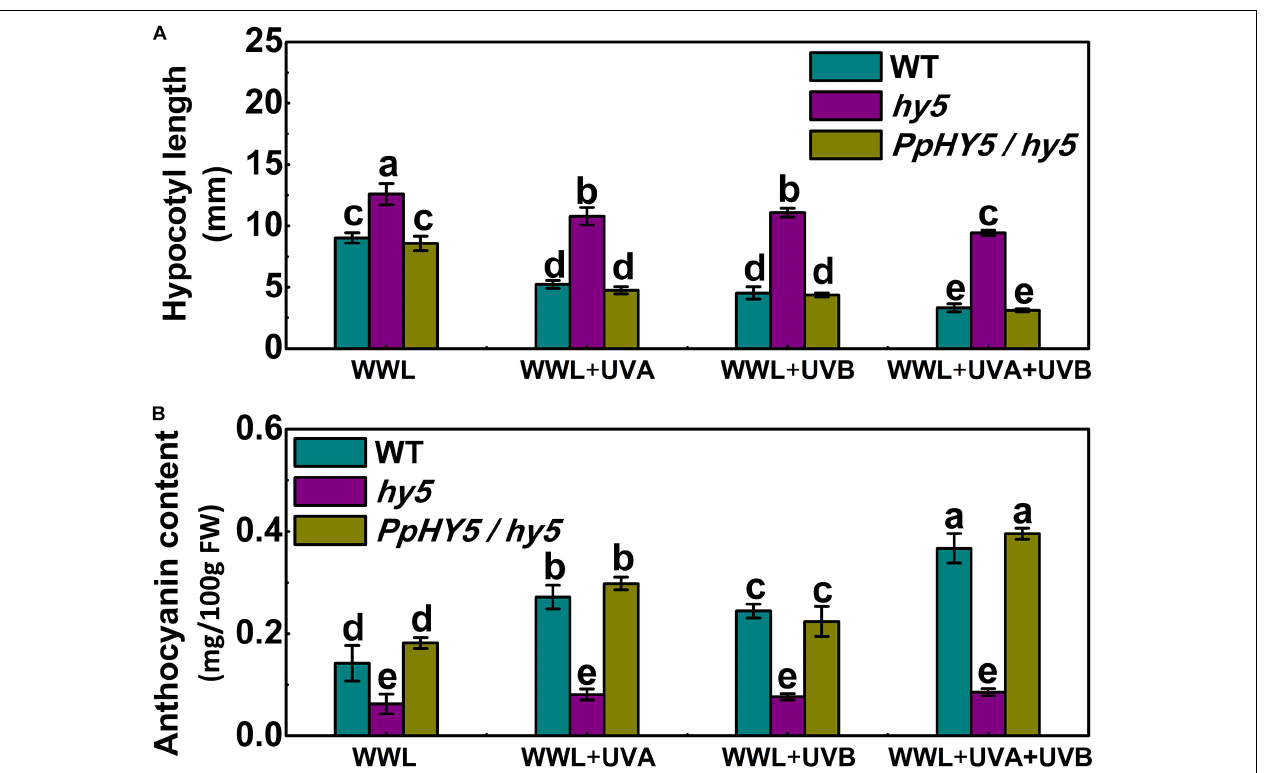
FIGURE 6 | Effect of different light treatments on hypocotyl length (A) and anthocyanin content (B) of 7-day-old seedlings of wild type (WT), hy5 mutant and PpHY5 / hy5 transgenic plant. Seedlings were grown under continuous weak white light (WWL, 40 µ w/cm 2 ) supplemented with/without UVA (40 µ w/cm 2 ) or UVB (10 µ w/cm 2 ) or both together for different UV light treatments. For Arabidopsis transgenic plant, three independent lines were used. Data were presented as means ( ± SE) from three independent biological replicates with 30 or more Arabidopsis seedlings collected for each replicate. Values labeled with different letters indicated a significant difference at P <